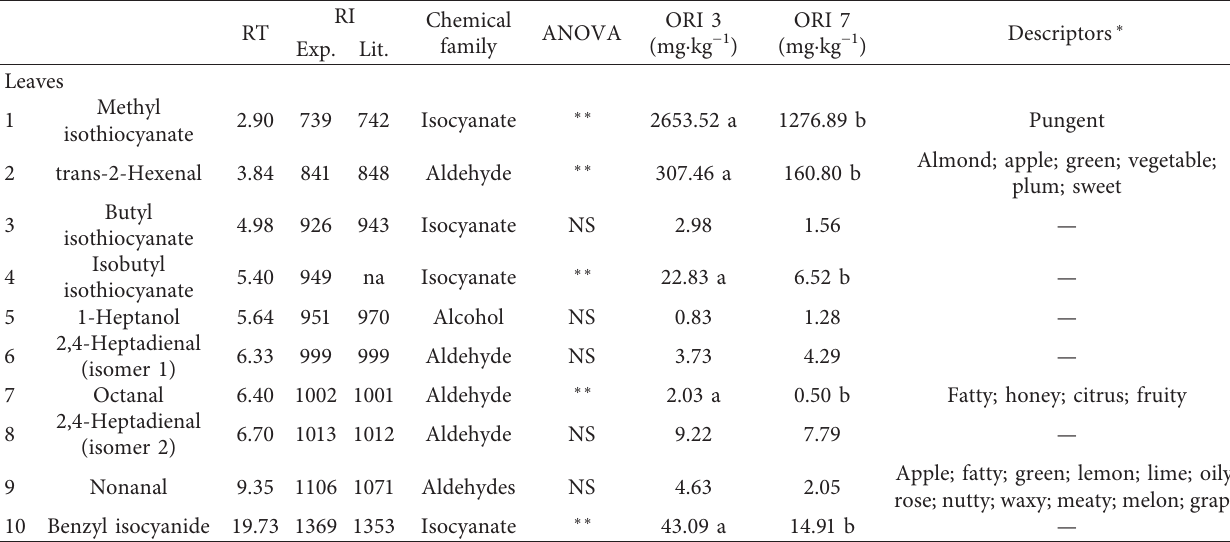
Table 3: Volatile compounds of Capparis spinosa L. in leaves and stems detected using headspace solid phase microextraction (HS-SPME) with